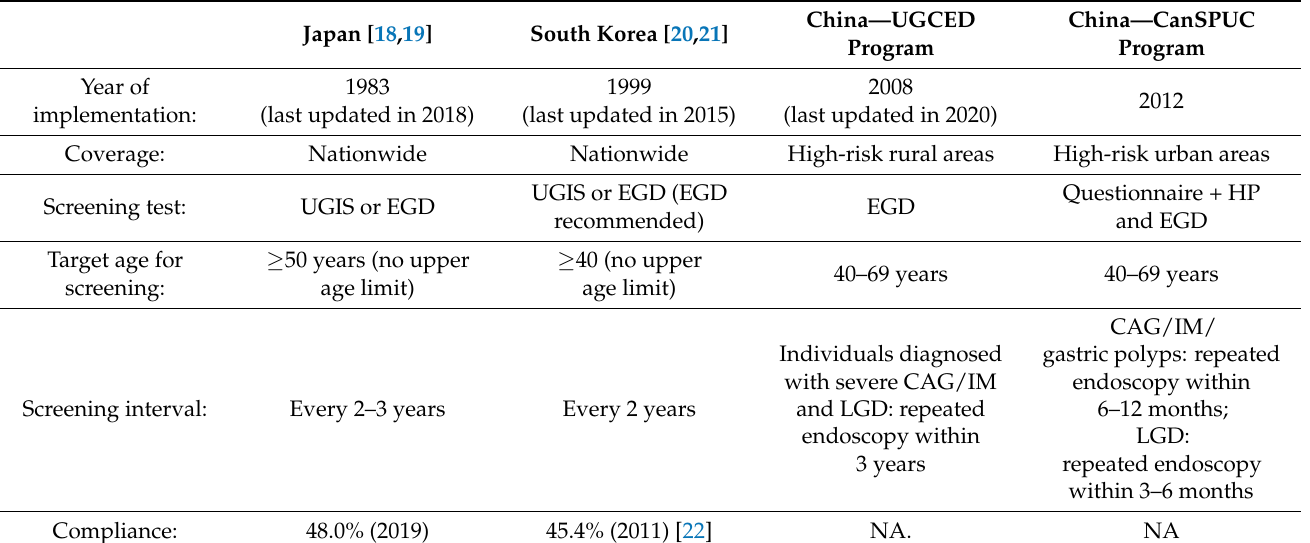
Table 1. Overview of screening programs in high-risk